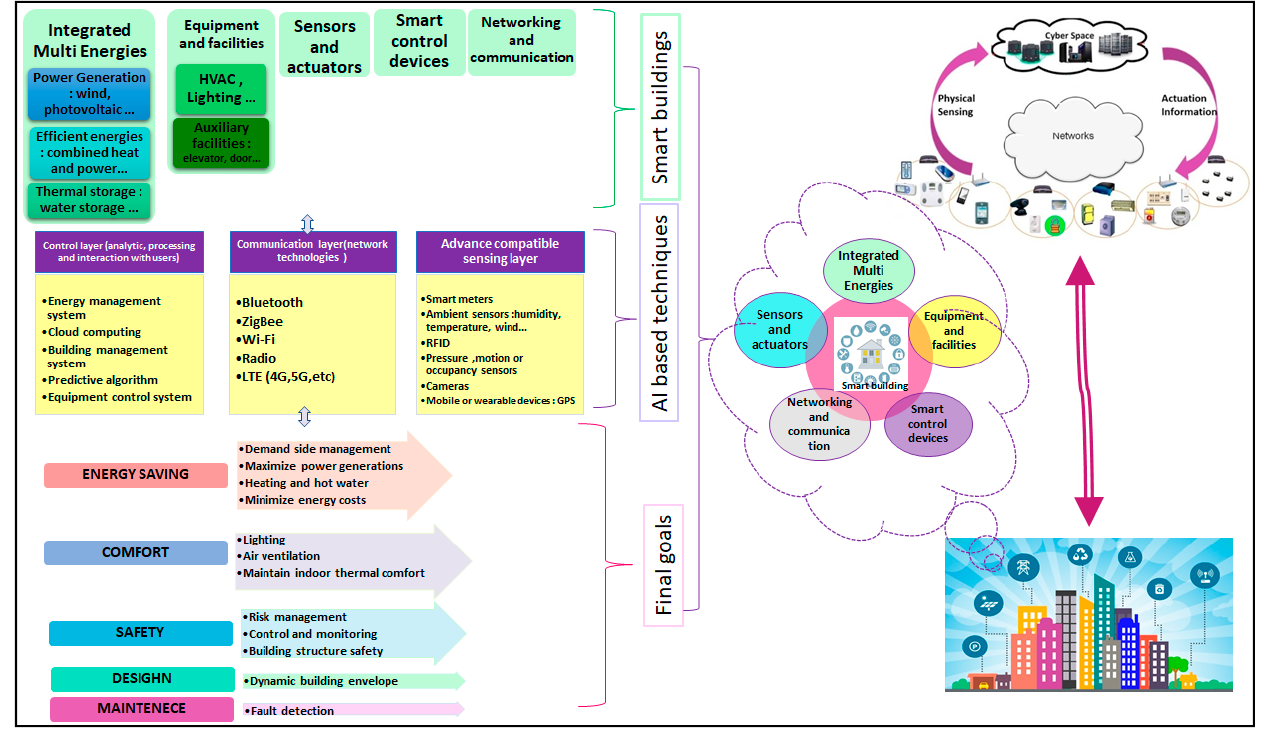
Figure 1. A cyber-physical system in a smart building (adapted from [37]).